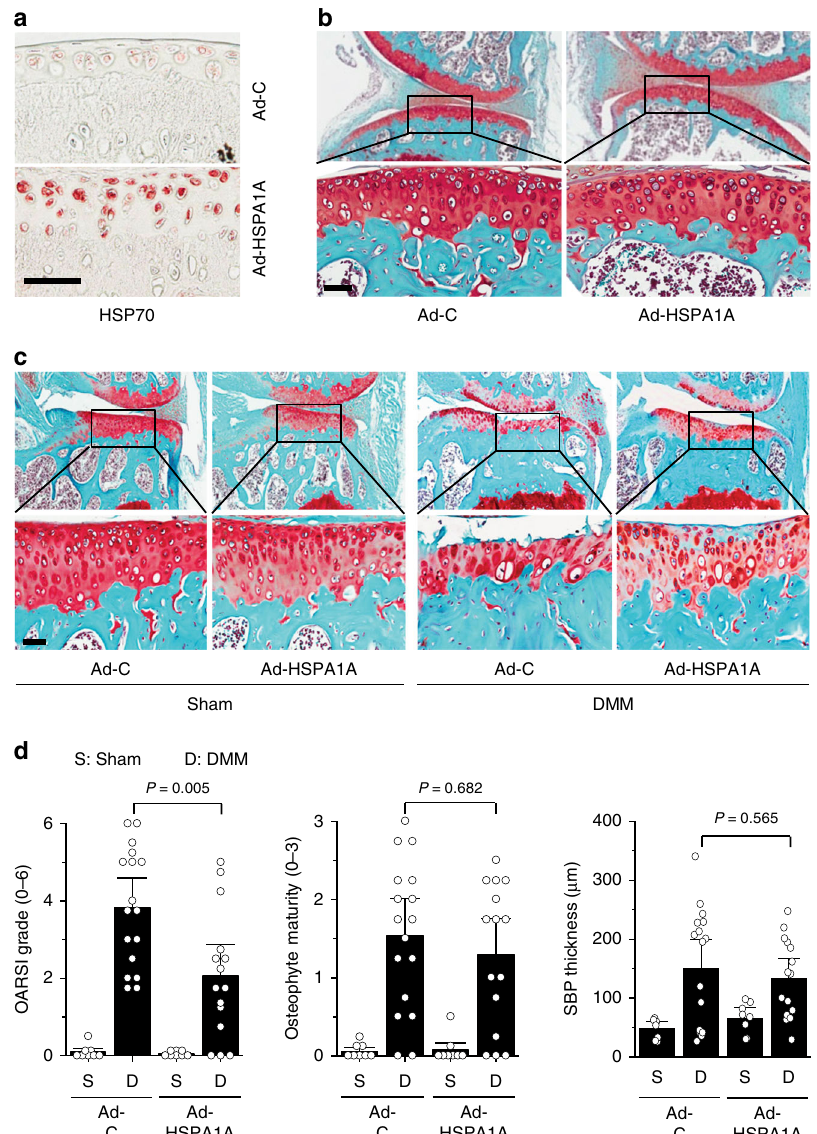
Fig. 5 HSPA1A protects against DMM-induced cartilage destruction. a , b Representative images of HSPA1A immunostaining in cartilage ( a ) and Safranin-O staining in joint sections ( b ) of mice IA injected with Ad-C or Ad-HSPA1A ( n = 5 mice per group) once a week for 3 weeks. c , d Representative Safranin-O staining images ( c ) and scoring of OARSI grade, osteophyte maturity, and subchondral bone plate thickness ( d ) in sham ( n = 8 mice per group)- or DMM ( n = 17 mice for Ad-C and 15 mice for Ad-HSPA1A)-operated mice subjected to IA injection of Ad-C as a control or Ad-HSPA1A to overexpress HSP70 in the joint tissues. Means± 95% CI with Mann – Whitney U test for OARSI grade and osteophyte maturity. Means ± s.e.m. with two-tailed t -test for SBP thickness. SBP subchondral bone plate. Scale bar: 50 μ